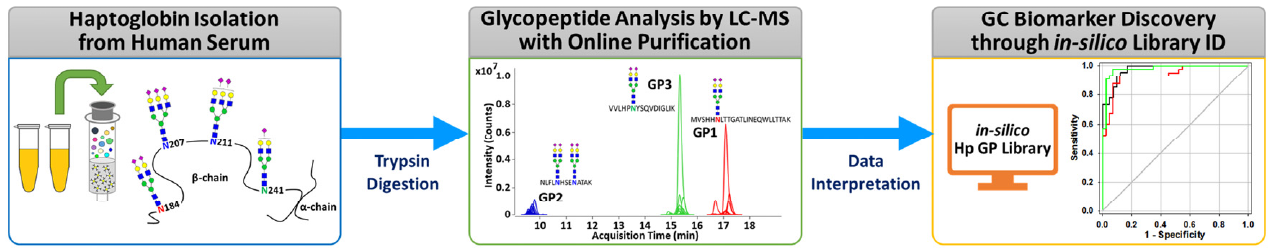
Figure 1. The overall experimental workflow of the middle-up-down glycoproteomic approach for aberrant glycosylation monitoring and gastric cancer